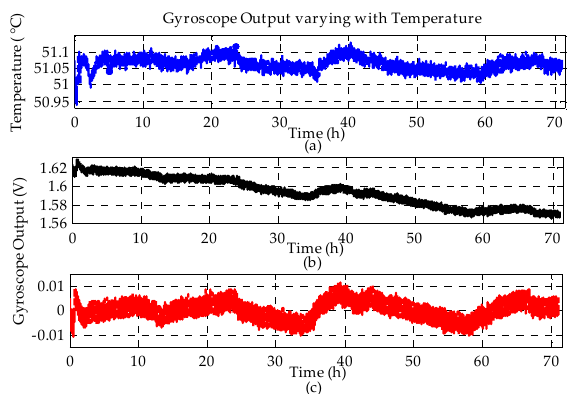
Figure 13. Long-term bias stability in a temperature-controlled environment: ( a ) working temperature; ( b ) raw drift of the MESG bias and ( c ) residual drift compensated by removing the slowly changing time drift.